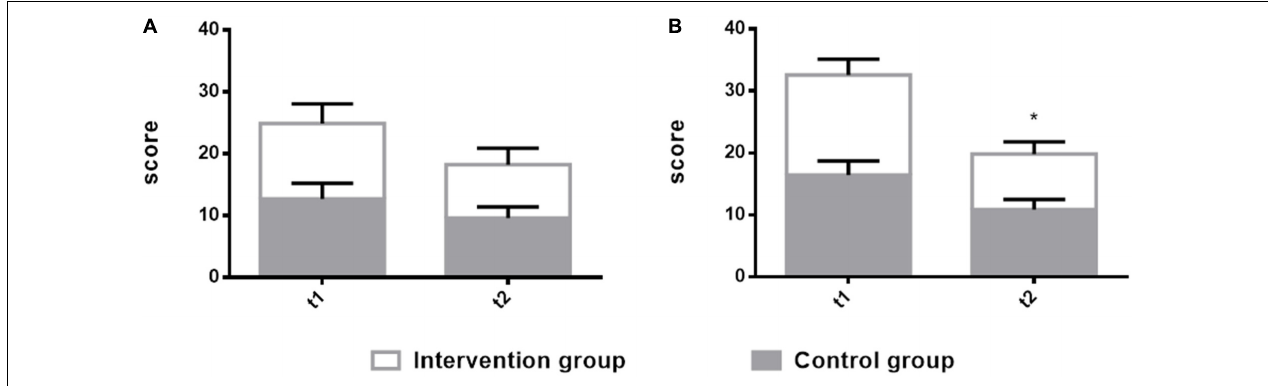
FIGURE 4 | Comparison of the Hamilton Anxiety Scale (HAMA) and the Hamilton Depression Scale (HAMD) in patients with non-fluent aphasia between the two groups with melodic intonation therapy and speech therapy. The intervention group: melodic intonation therapy group; the control group: speech therapy group. (A) HAMA; (B) HAMD. Data are expressed as mean ± SD ( n = 20) and analyzed by repeated-measures analysis of variance. * p < 0.05, ** p < 0.01. t 1 , baseline; t 2 , after 8